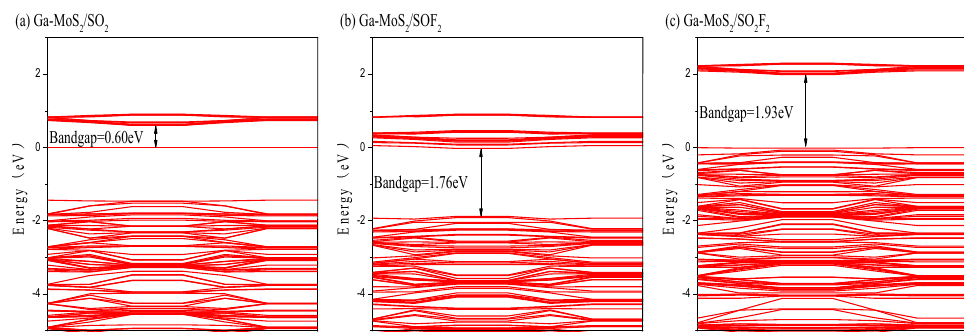
Figure 8. The energy band of ( a ) Ga-MoS 2 /SO 2 ( b ) Ga-MoS 2 /SOF 2 ( c ) Ga-MoS 2 /SO 2 F 2 adsorption system.